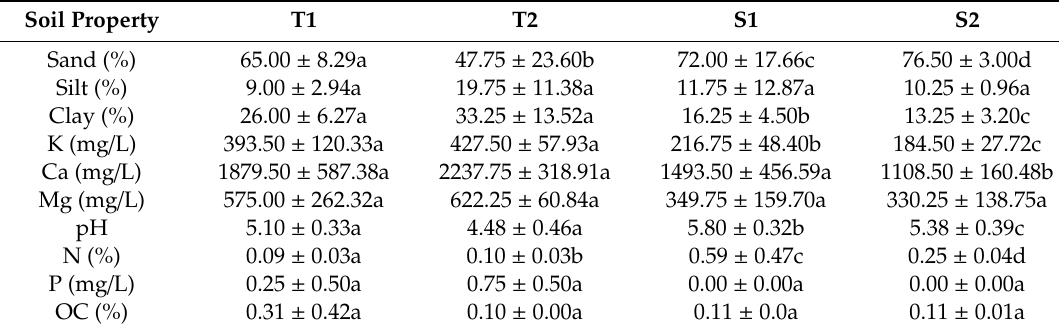
Table 2. Soil analysis of termite mound soils and their comparative surrounding soils.